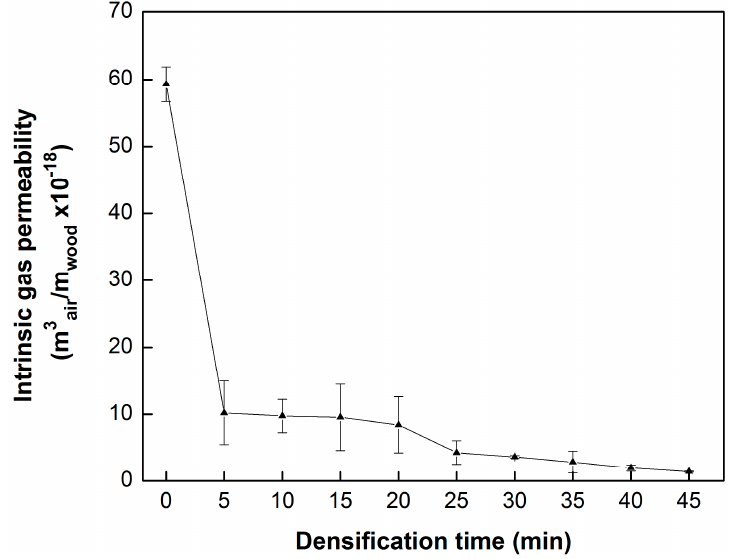
Figure 7. Evolution of the radial intrinsic gas permeability during the densification process. Table 3. Analysis of variance results of the radial intrinsic gas permeability versus densification time.